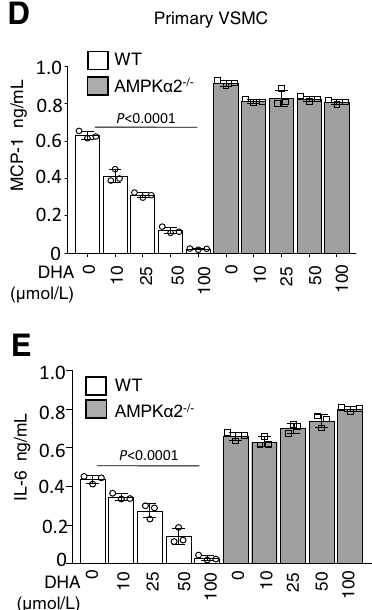
de fi cient-VSMCs treated with or without PA (300 μ M) and DHA (0, 10, 25, 50, 100 μ M).Thedatashownrepresentoneofthreeseparateexperiments( n =3).DHA treatment group analysis by one-way ANOVA test. VSMC vascular smooth muscle cell, WT wild type, DHA docosahexaenoic acid, MCP-1 monocyte chemoattractant protein-1, IL-6